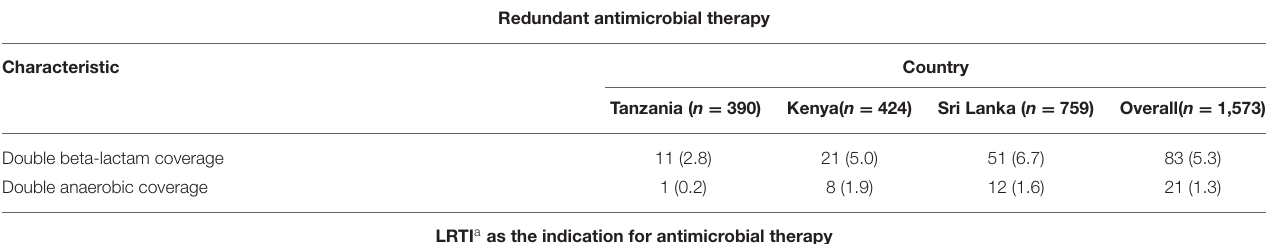
TABLE 3 | Appropriateness of antimicrobial therapy across study sites in Tanzania, Kenya, and Sri Lanka. Redundant antimicrobial